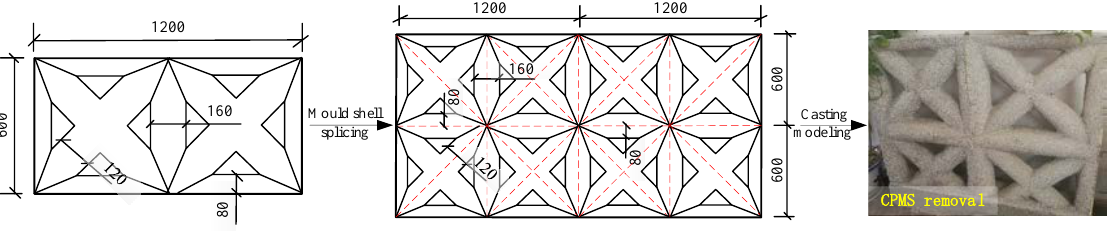
Figure 3. Schematic diagram of CPMS ‘star-type’ grid concrete wall.